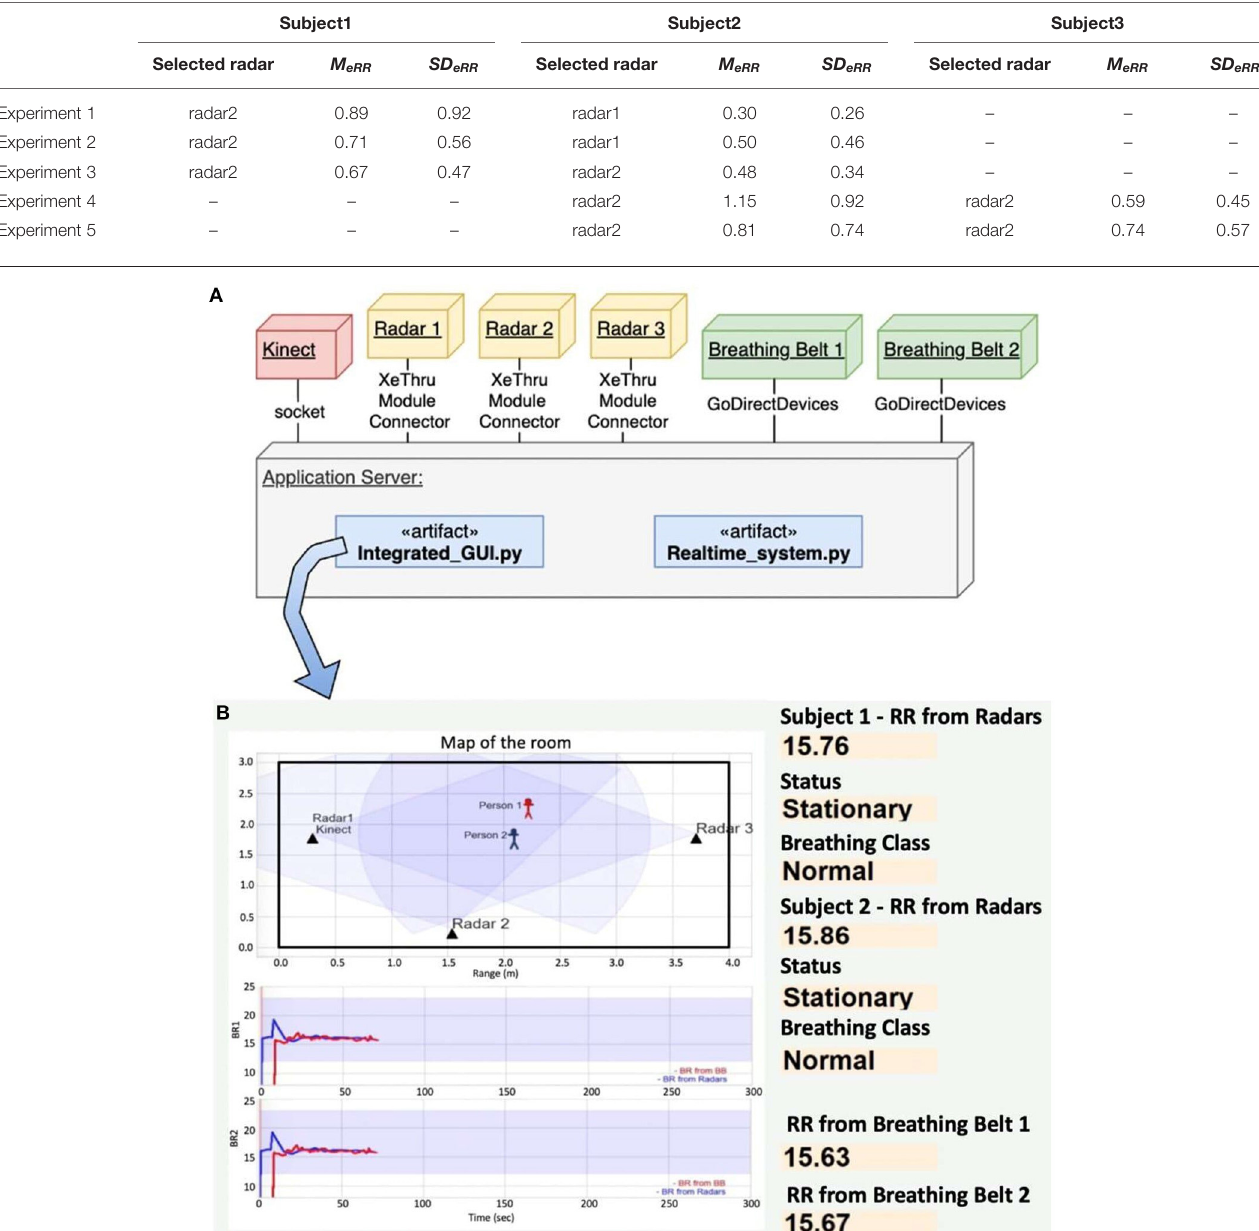
TABLE 5 | The selected radar, mean and standard deviation of the RR estimation error between the estimated RR and the reference RR of two-subject experiments (unit:breaths/min).